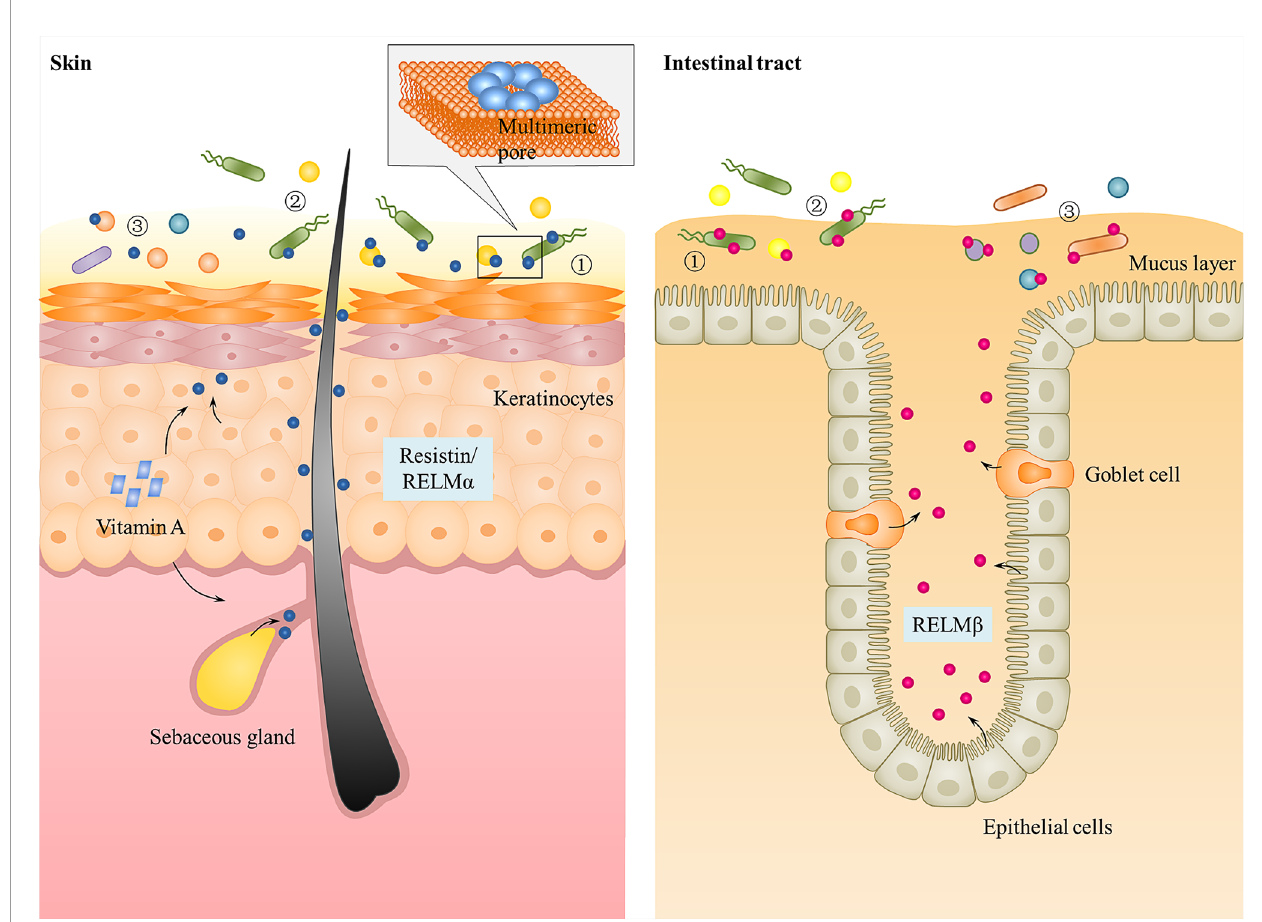
FIGURE 2 | Function of resistin and the other RELMs in skin and intestinal epithelium. Human resistin and mouse RELM a are expressed in keratinocytes and sebaceous glands of skin that can be triggered by bacterial colonization and Vitamin A. Mouse and human RELM b are expressed by goblet cells and epithelial cells into gastrointestinal tract mucus layer. They kill bacteria by binding to bacterial lipids and forming multimeric pores in bacterial membranes. All RELMs not only ① protect against pathogen colonization, but also ② limit access of the microbiota to host tissues and ③ determine microbiota